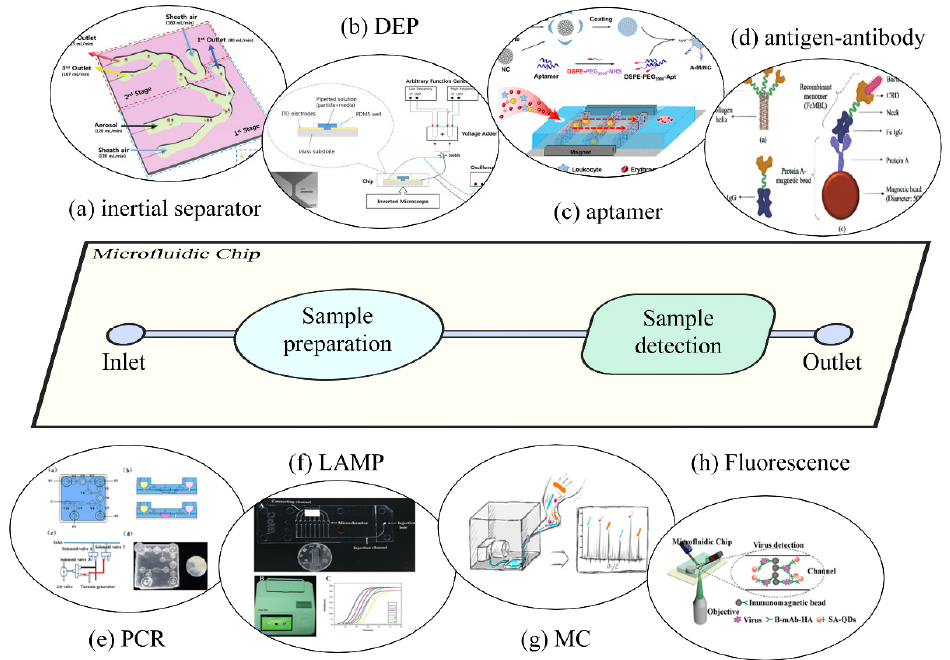
Figure 3. Schematic illustration of on-microchip microsample analysis, combining ( a – d ) on-chip purification of target microsample and ( e – h ) detection methods for applications (( a ) Adapted with permission from [55] . Copyright {2015} American Chemical Society. ( c ) Adapted with permission from [56] . Copyright {2019} American Chemical Society. ( d ) Adapted with permission from [57] . Copyright {2021} American Chemical Society. ( f ) Adapted with permission from [58] . Copyright {2018} American Chemical Society. ( g ) Adapted with permission from [59] . Copyright {2016} American Chemical Society. ( h ) Adapted with permission from [60] . Copyright {2013} American Chemical Society).